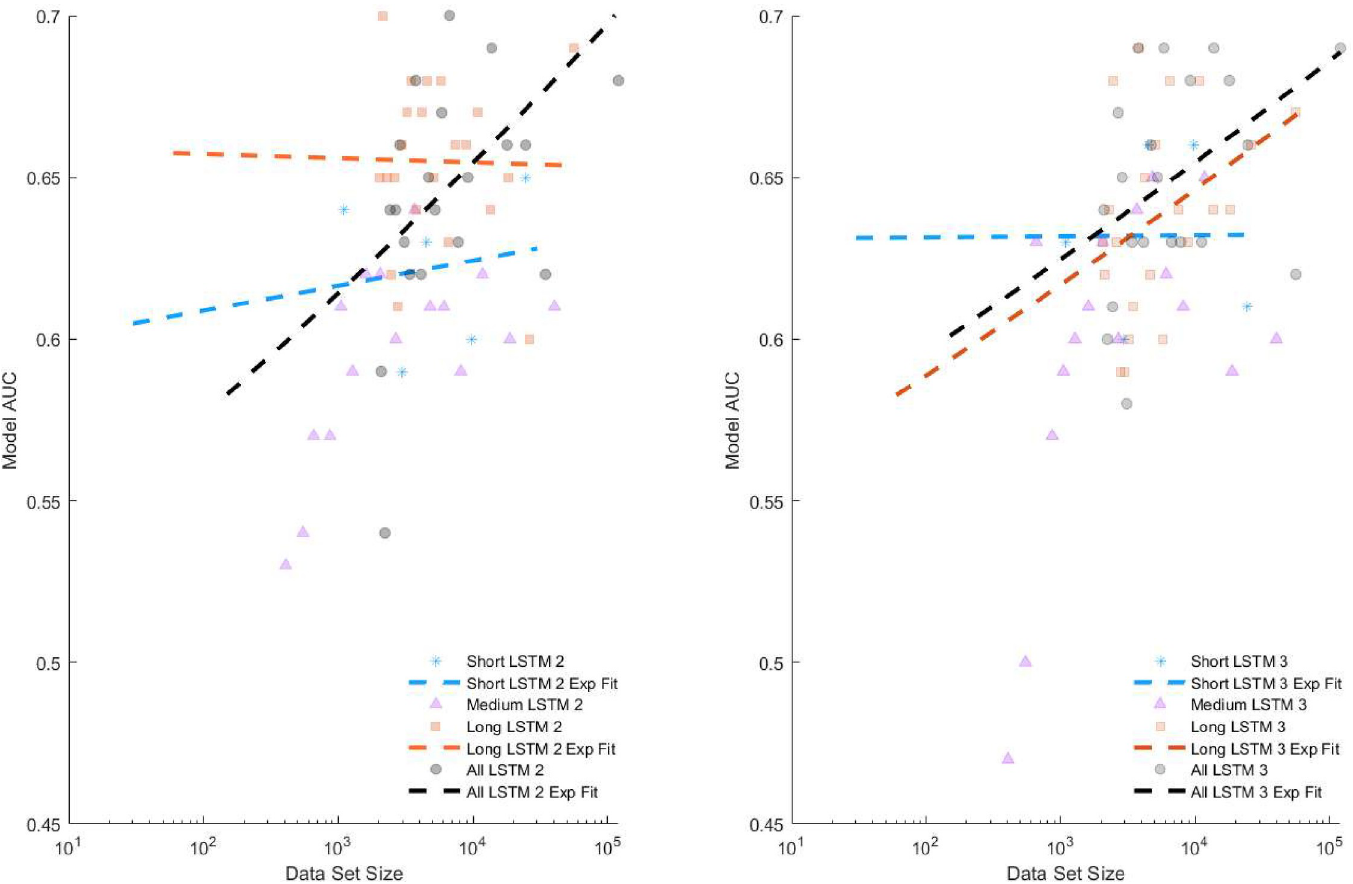
Fig 4. Fall risk classification model AUC for LSTM 2 ABC and LSTM 3 ABC for all stride durations colored by bout length, short (blue), medium (pink), long (red), and all (black), plotted against the training set size for each model showing increasing performance, increasing exponential fits, for several model/bout configurations with data set size. Notice the stronger increasing trends in the right LSTM 3 plots in all and long bouts compared to the LSTM 2 plot. Additionally notice the increase in slope of short LSTM 2 compared to short LSTM 3. This suggests that the larger models are needed to capture variability in longer bouts and smaller models perform better with shorted bouts. Note, the medium trend (not shown) was strongly increasing for both LSTM 2 and 3.